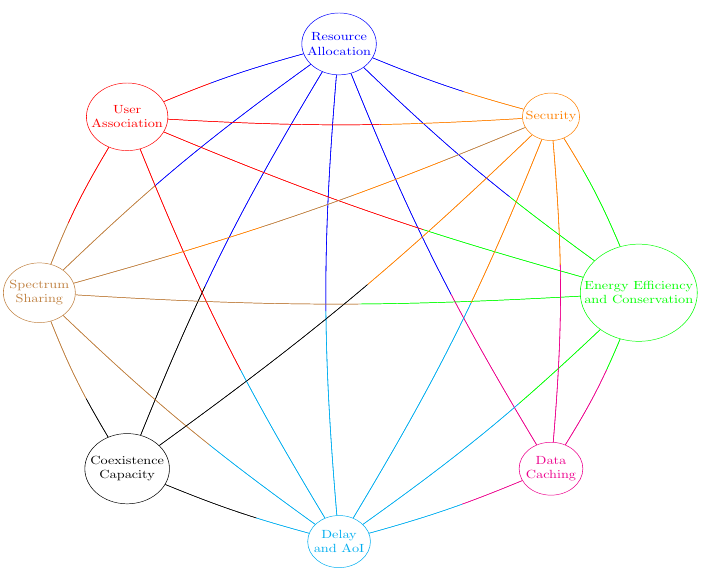
Figure 9. Graph-based model of the design process for resource management algorithms (adapted with permission from Ref. [108]. 2020